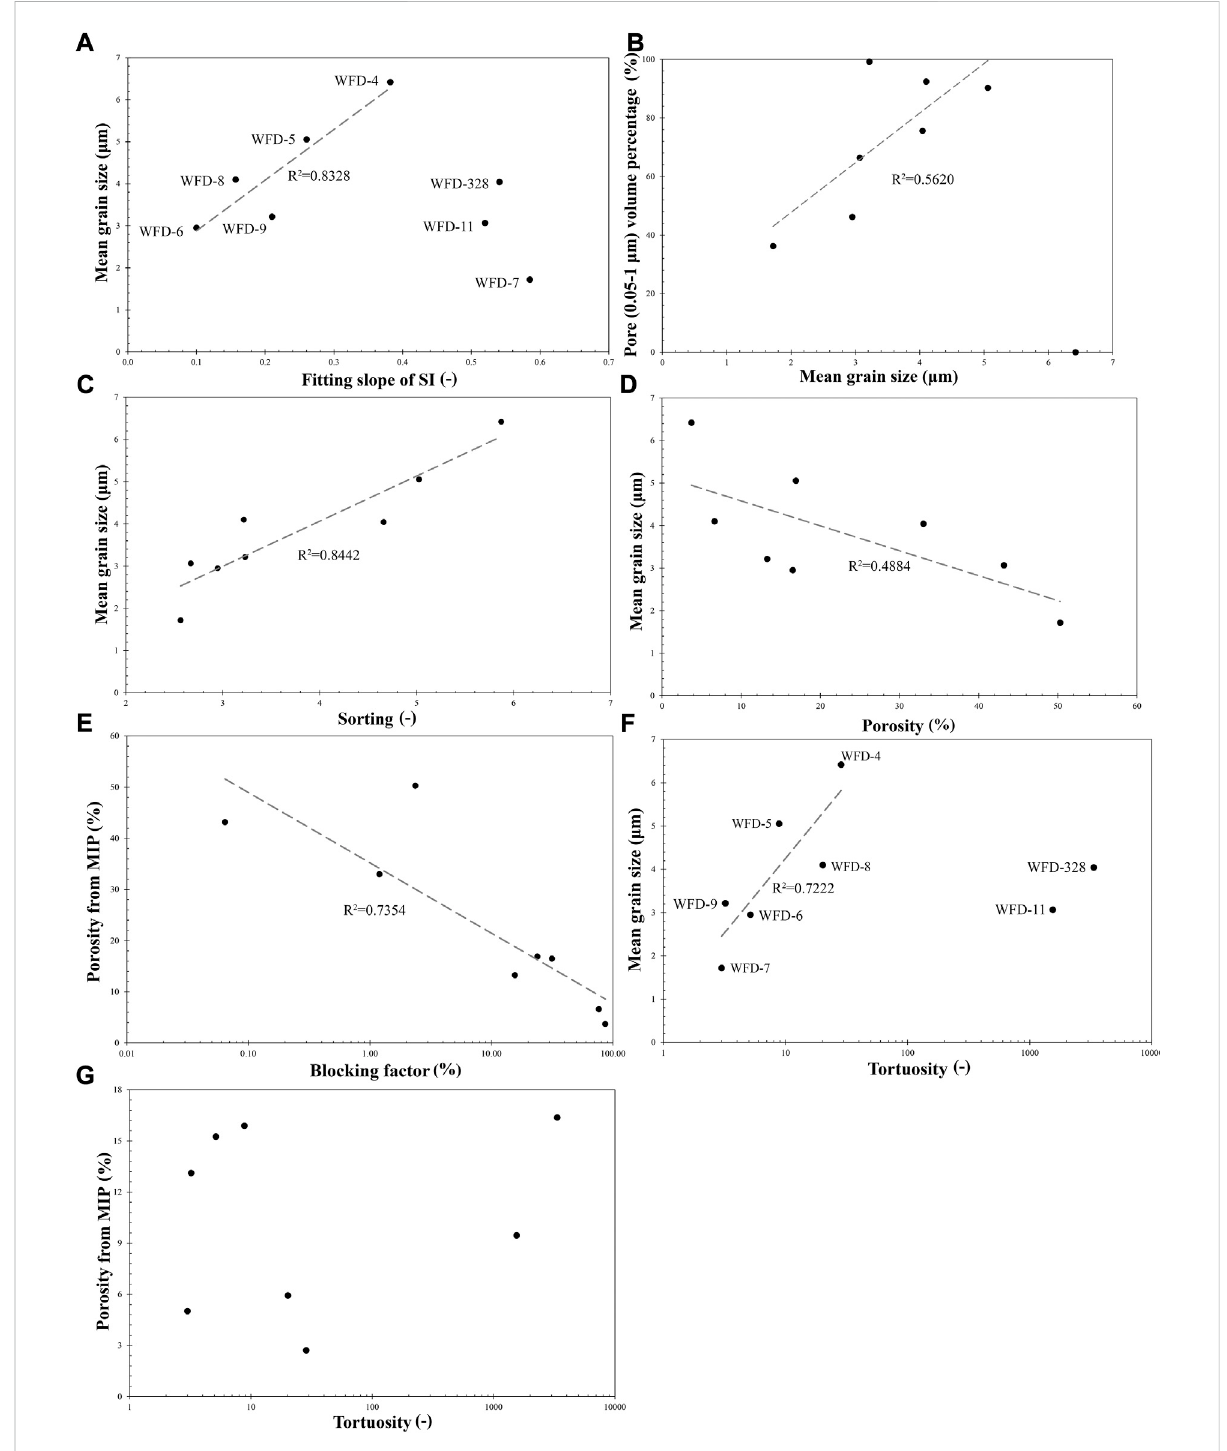
FIGURE 11 Cross plots of (A) mean grain size vs. fi tting slopes; (B) nanopore percentage vs. mean grain size; (C) porosity vs. tortuosity; (D) porosity vs. blocking factor; (E) mean grain size vs. sorting; (F) mean grain size vs. porosity; and (G) mean grain size vs. tortuosity; (-) means